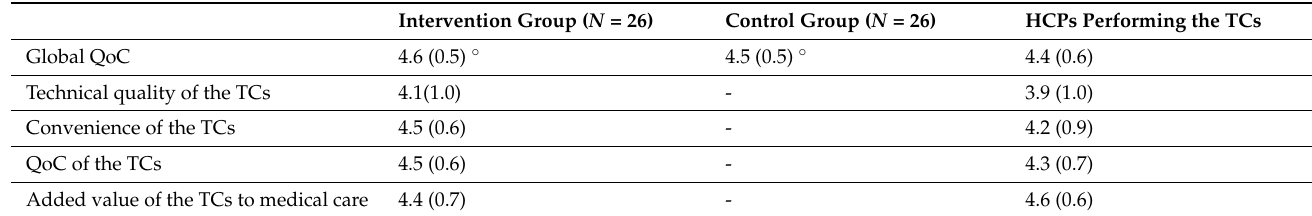
Table 4. Satisfaction as quantified from 5-point Likert scales with regard to patients who completed the study